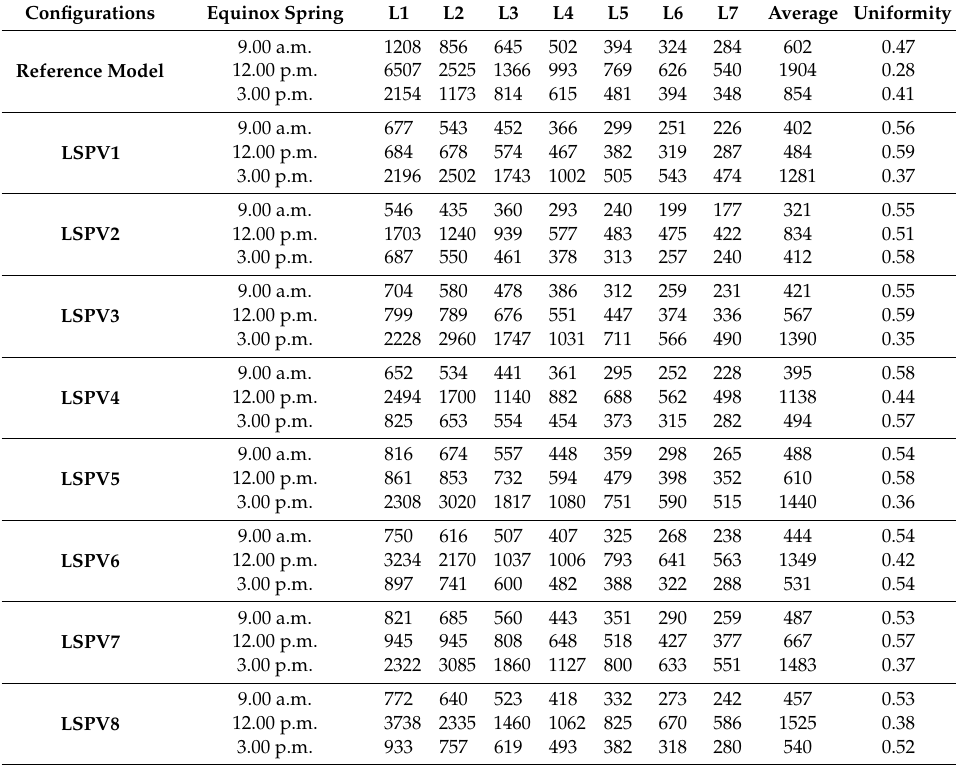
Table 9. The point in time illuminance of PV integration with light shelves and uniformity at